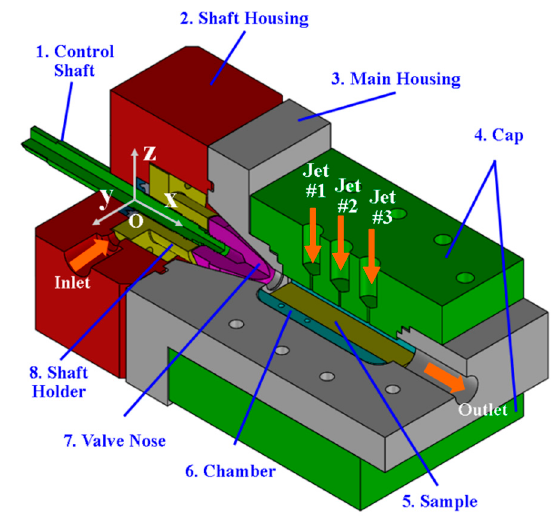
Figure 4. Multiple-jet cavitation device. Figure 4. Multiple ‐ jet cavitation device. Figure 4. Multiple ‐ jet cavitation device.